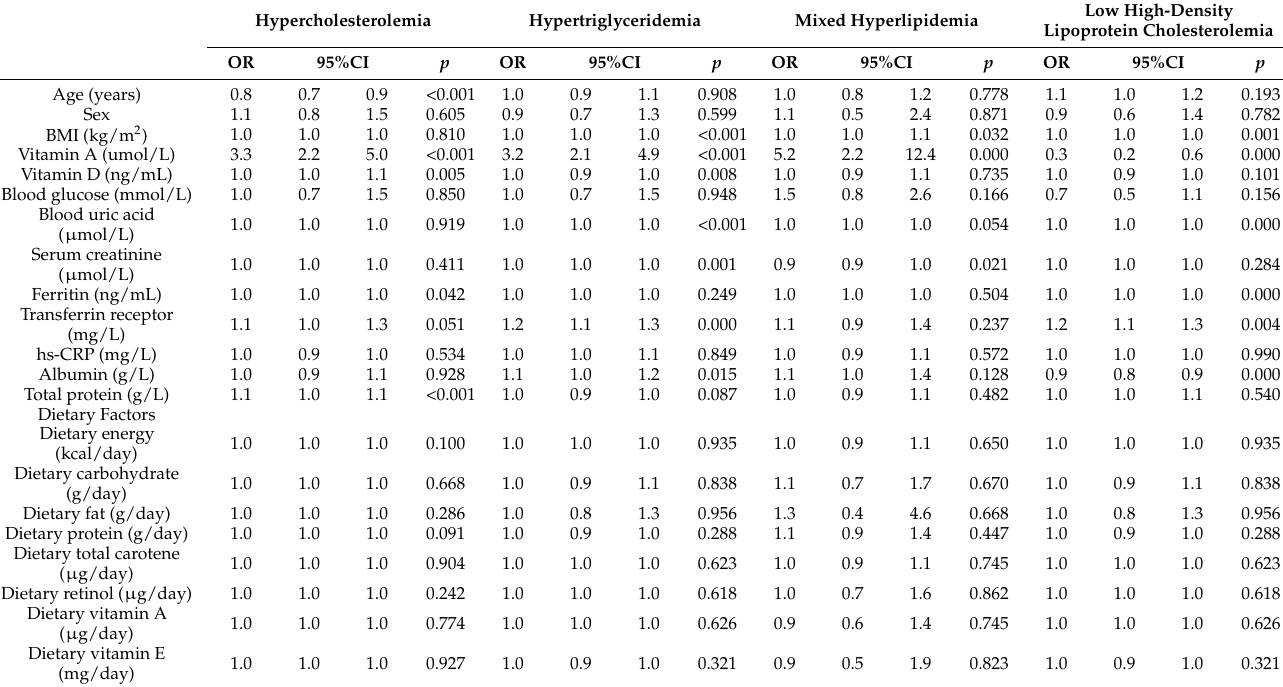
Table 3. Logistic regression analysis of the relationship between dyslipidemias and risk